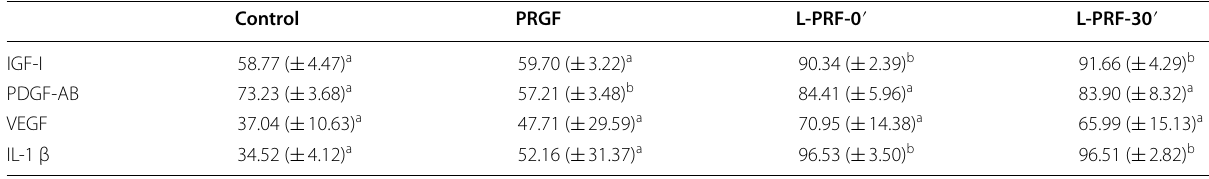
Equal letters show that there are no statistically significant differences within groups. Note that comparisons refer exclusively to data in the same row